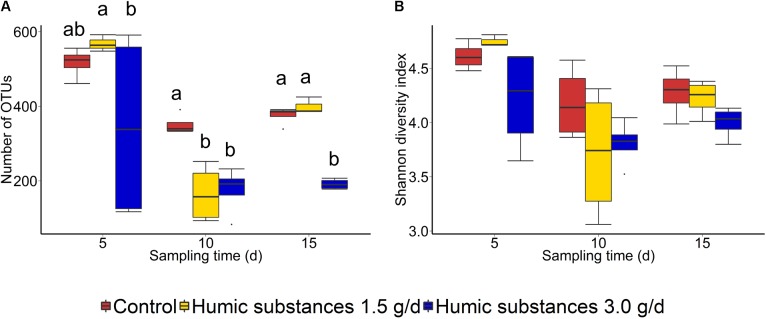
Box plots of the (A) number of OTUs and (B) Shannon diversity index for solid-associated microbe (SAM) samples by treatment and sampling time. Different lowercase letters within each sampling time indicate significantly different means (P < 0.05).